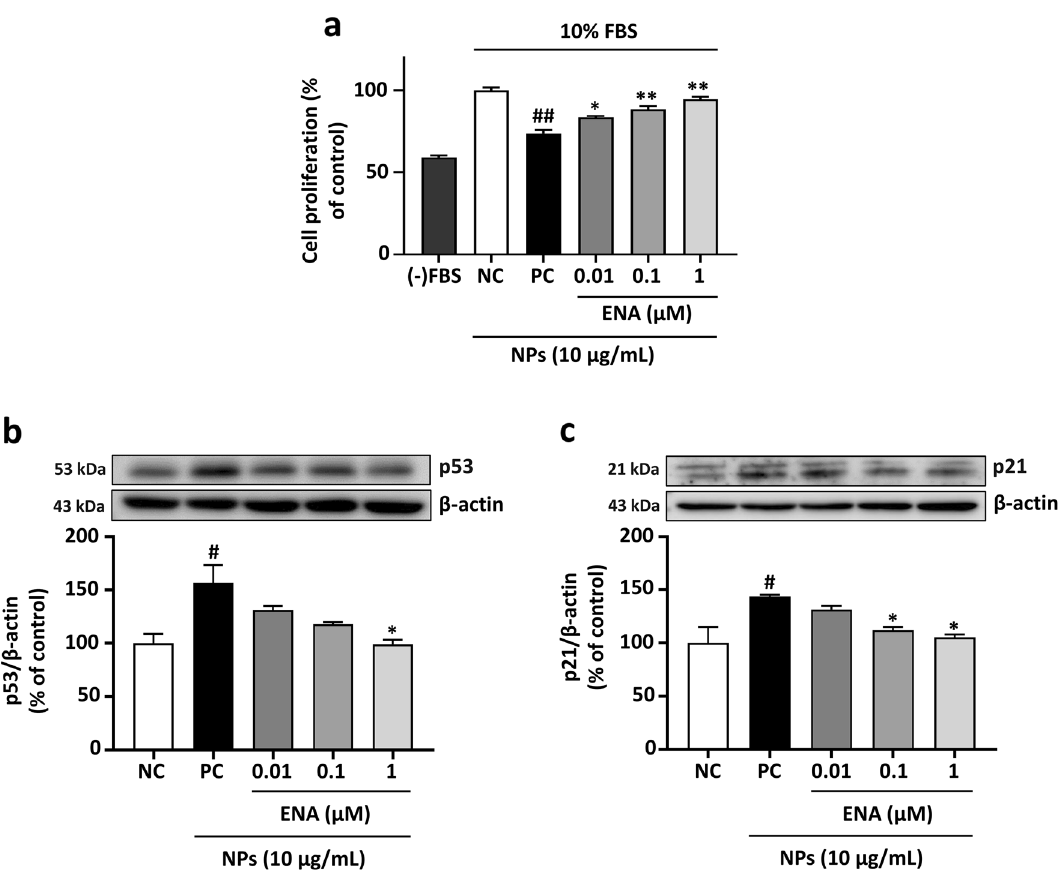
Figure 3. SGLT2 inhibition increases cell proliferation and down-regulates the cell cycle regulatory proteins expression altered by NPs exposure. ( a ) Cell proliferation of PCAECs treated with or without NPs (10 μg/ mL) alone or with ENA (0.01, 0.1, 1 μM) for 24 h. Data are the mean ± SEM (n = 6). *p < 0.05; ** p < 0.01 vs. PC (complete media + NPs 10 μg/mL); ## p < 0.01 vs. NC (complete media). ( b-c ) Representative immunoblots for cell cycle regulatory proteins: p53 and p21 (lower band) with their corresponding cumulative data. Data are the mean ± SEM (n = 3–4). * p < 0.05 versus PC; # p < 0.05 versus